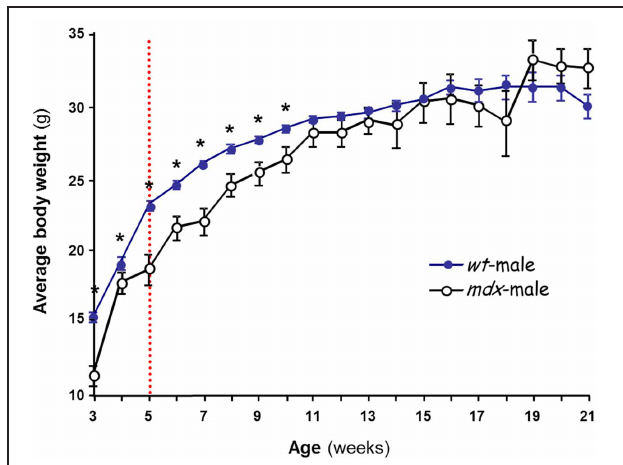
FIGURE 1 | Postnatal changes in body weight in male mice. The effect of strain on body weight is shown. Several litters of C57BL/ 10J ( wt , • ) and mdx ( ◦ ) male mice were weighed over 3–21 weeks. Each data point is the mean ± SEM ( n = 6–34). The dashed line at ∼ 5 weeks marks initiation of puberty in the wt . ∗ p < 0 . 05 between wt and mdx of the same age, showing that mdx mice gain less weight than wt during postnatal development but reach normal level by 11